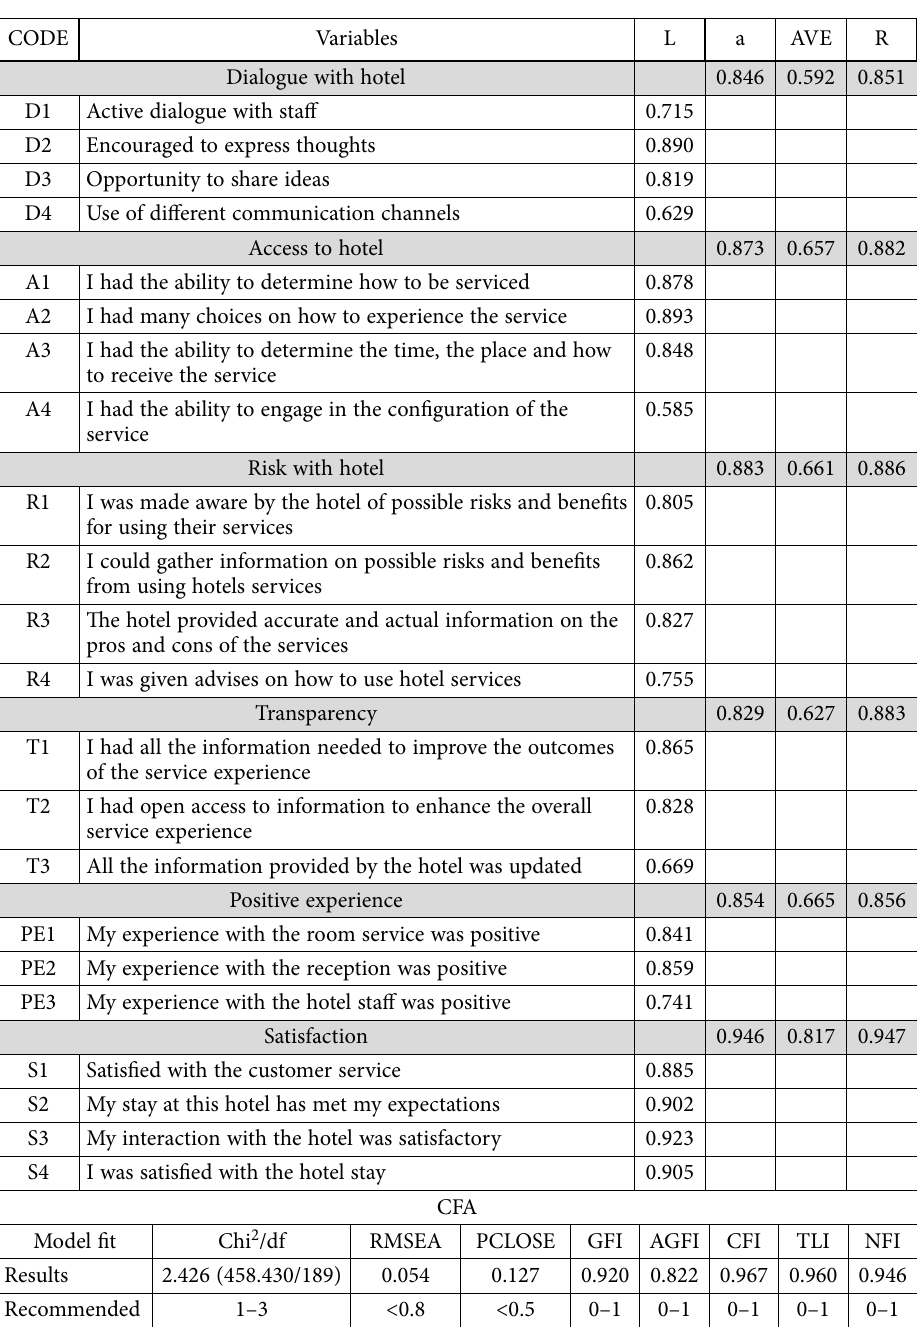
Table 2. Constructs and results and